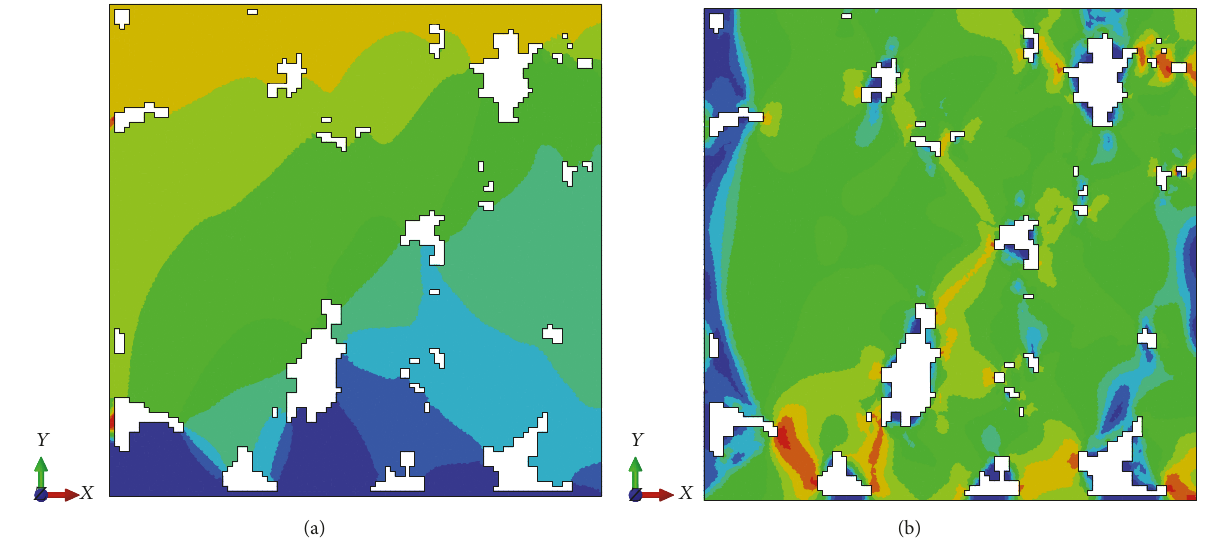
Figure 9: The RVE diagram ((a) depicts the displacement contour and (b) depicts the stress contour).